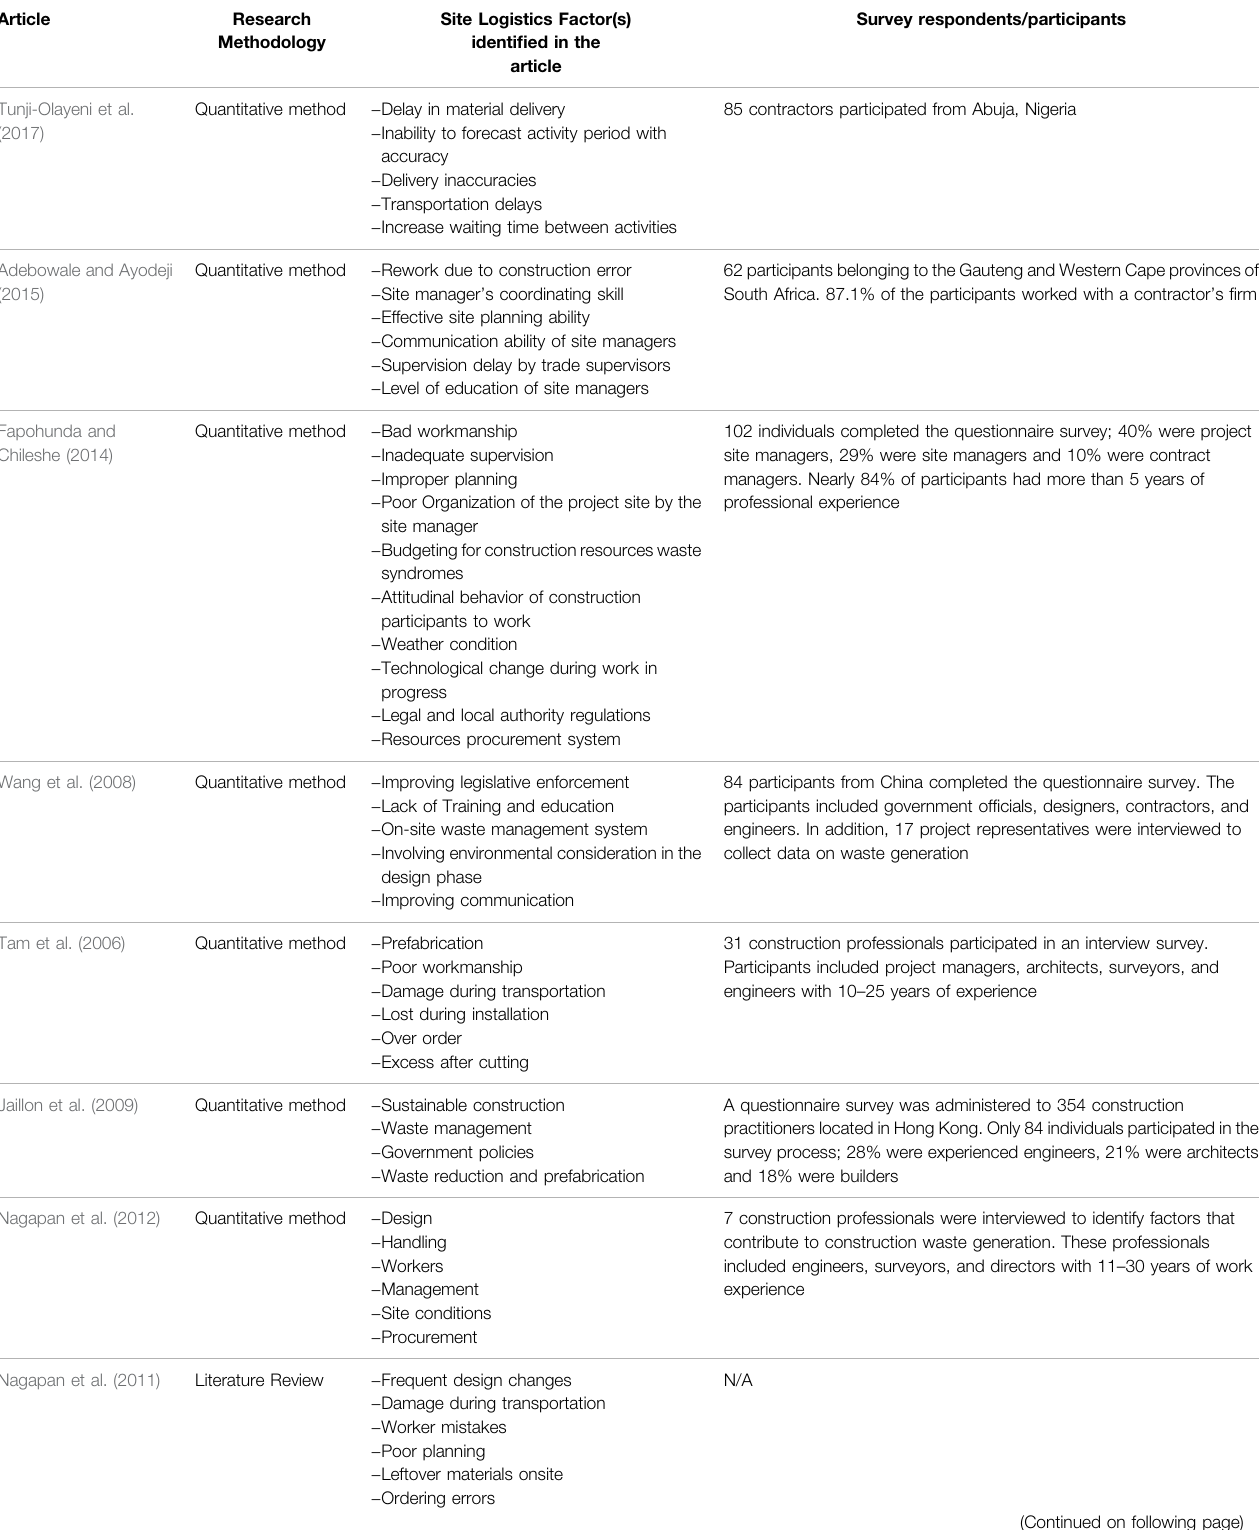
TABLE 1 | Site logistics factors identi fi ed by the corresponding